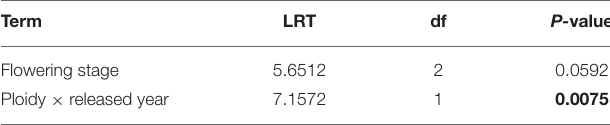
TABLE 3 | Ordinal regression of cumulative link mixed model (CLMM) (LRT, likelihood ratio test statistic) for the effects of flowering stage, ploidy, and released year on the seed number per pollinated floret in red